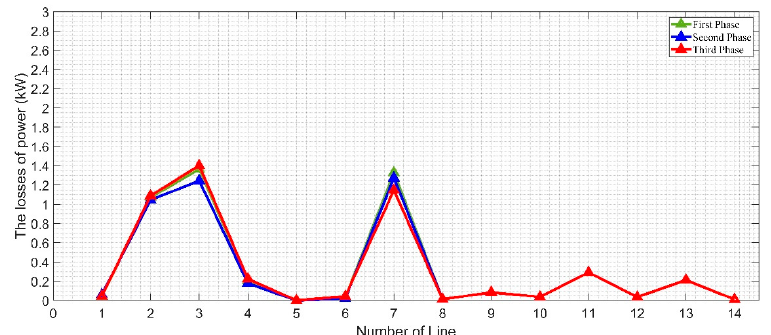
Figure 21. Minimum demand power losses per phase.